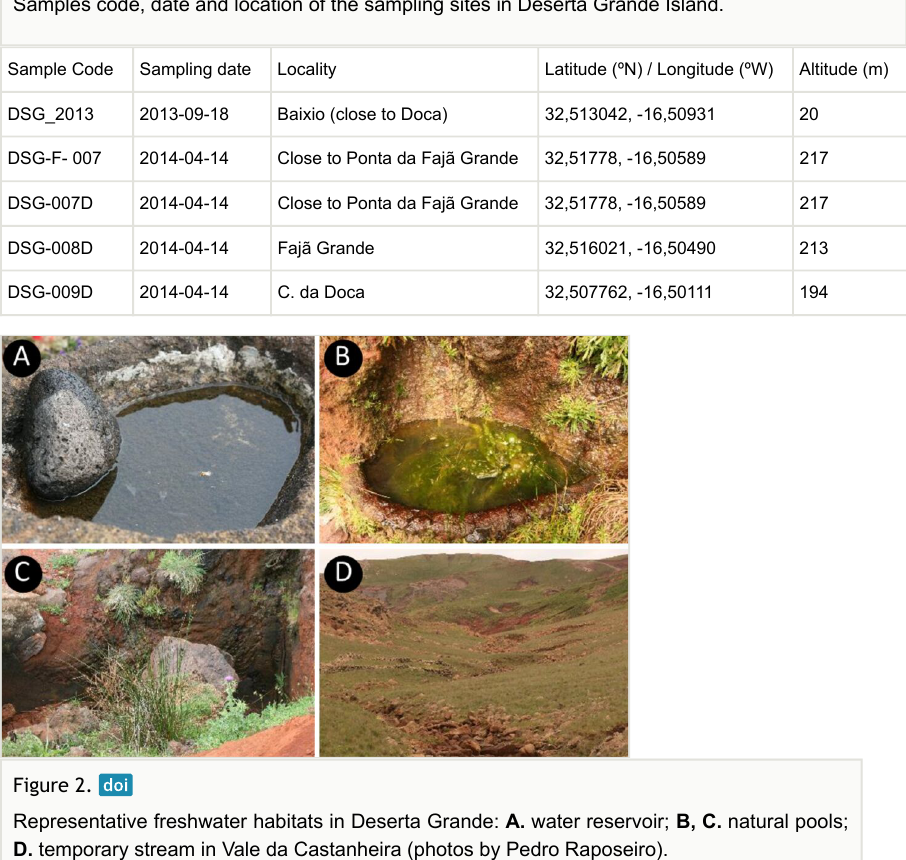
Representative freshwater habitats in Deserta Grande: A. water reservoir; B, C. natural pools; D. temporary stream in Vale da Castanheira (photos by Pedro